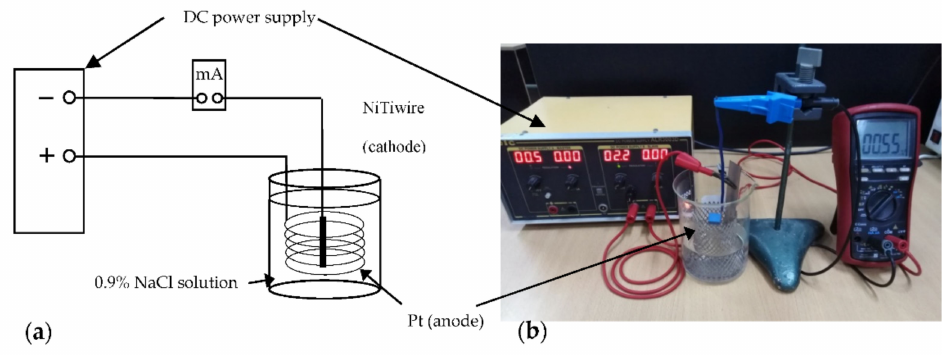
Figure 2. ( a ) Scheme of hydrogen charging ( b ) setup by electrolysis. After immersion for 3 h and ultrasonic cleaning with acetone for 5 min, the